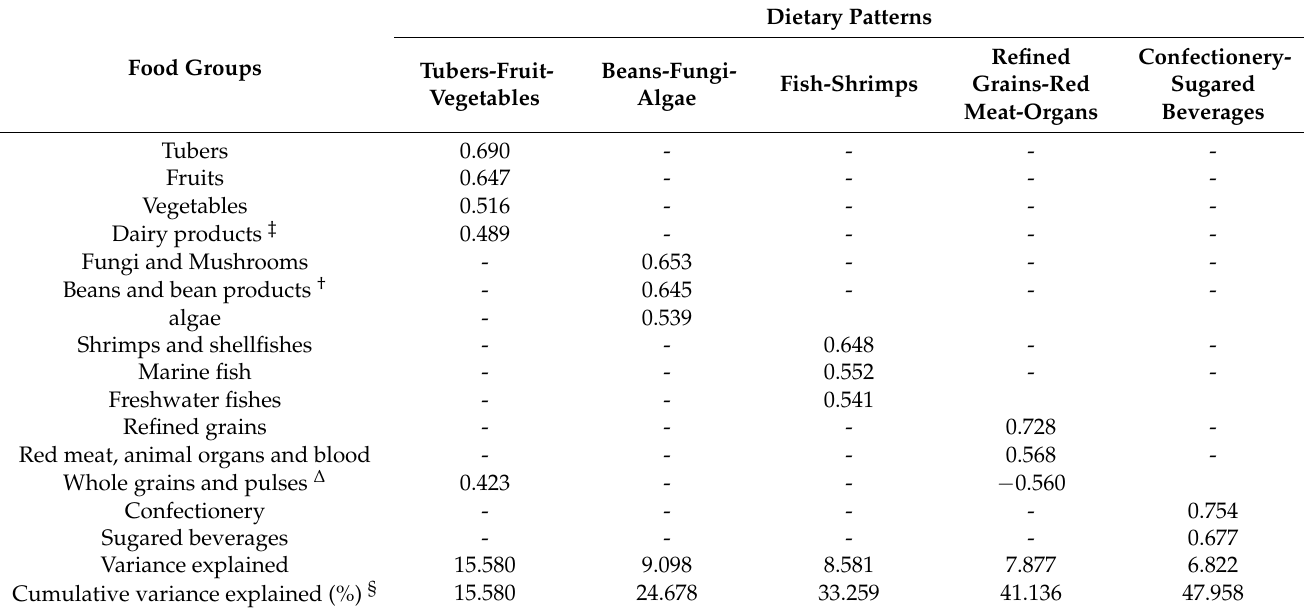
Table 2. Factor loading matrix of food groups for the five major dietary patterns identified by Principal Component Analysis (PCA) based on two 3-d food records in pregnant women, Shanghai, China *.